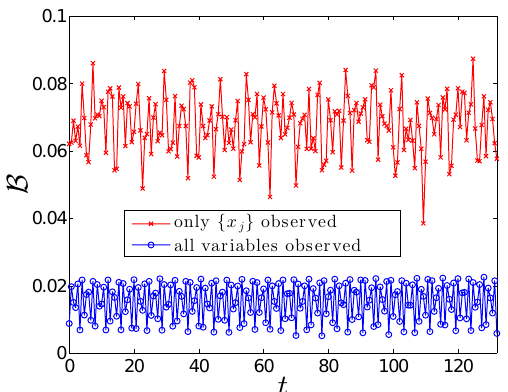
Fig. 3. Imbalance B of the analysis as a function of analysis cycles for ETKF with 1000 ensemble members and an observation inter- val of 1t obs =2h and observational noise error variance R o =0.84, without covariance inflation and localisation. Results are shown for the case when all variables { x j } , { h j } and { ˙ h j } of the modified slow- fast Lorenz-96 model (Eqs. 17–18) are observed (blue) and for the case of a spatially sparse observations when only { x j } are observed